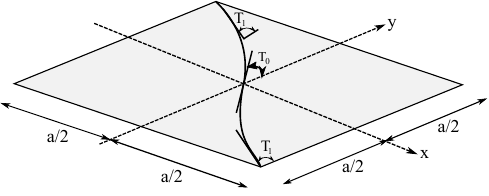
Figure 3. Variable angle tow